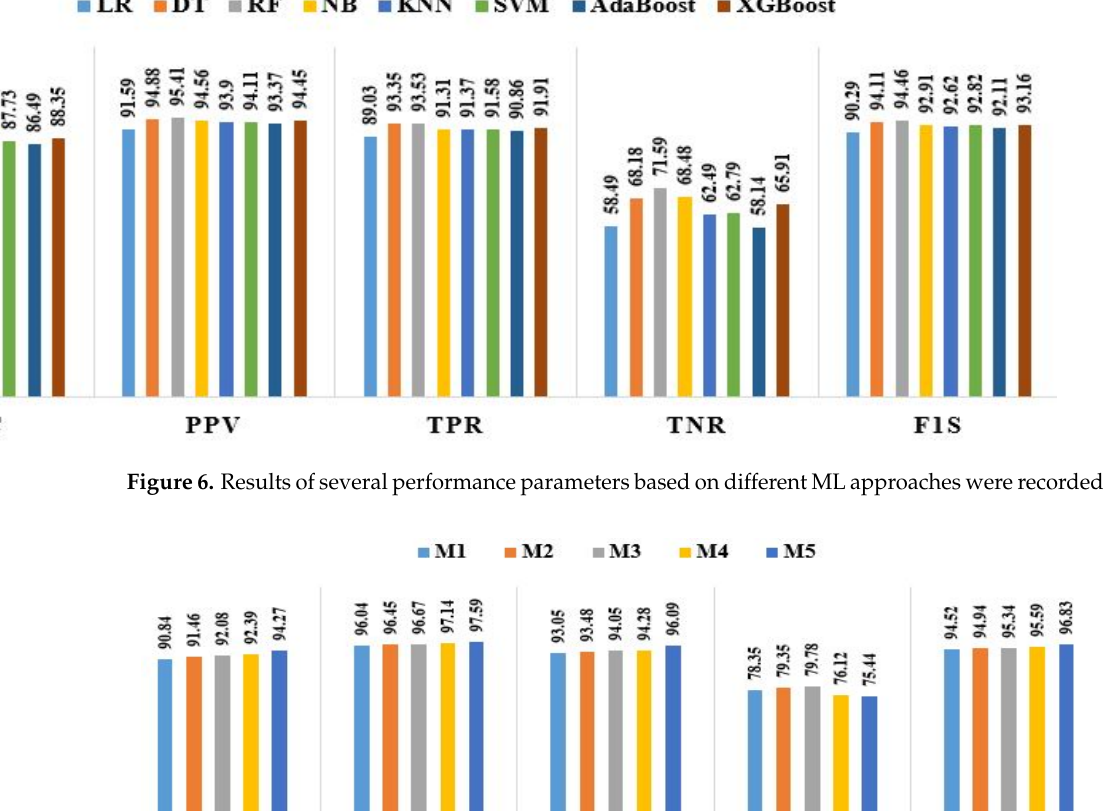
Figure 7. The results of several performance parameters were recorded using different ensemble techniques.